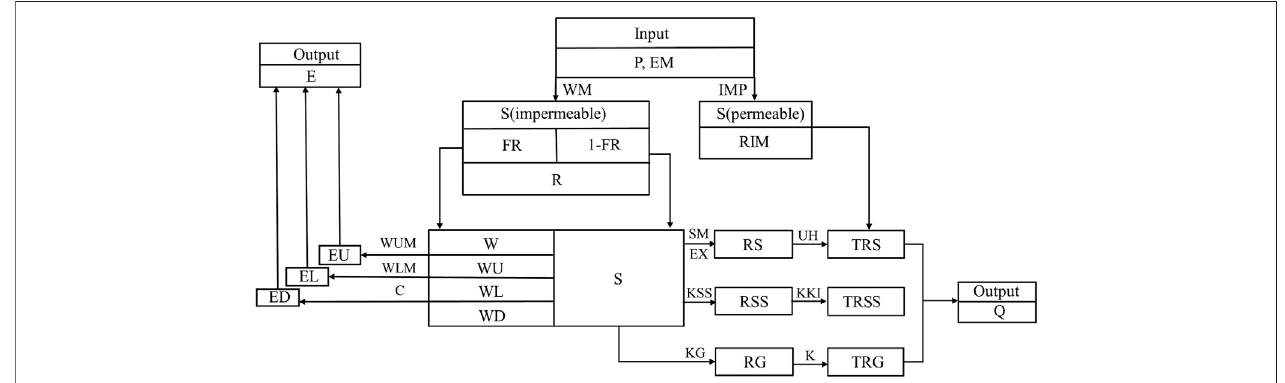
FIGURE 2 | Flow chart for the Xinanjiang model (XAJ) model (Zhao, 1992). Note: P, precipitation; EM, potential evaporation; S, free water storage; FR, area ratio with runoff generation; W, total soil moisture; WU, upper layer soil moisture; WL, lower layer soil moisture; WD, deeper layer soil moisture; EU, upper layer soil evaporation;EL,lowerlayersoilevaporation;ED,deeperlayersoilevaporation; E,actualevaporation; WUM,thesoilwaterstoragecapacityofupperlayer;WLM,thesoil waterstorage capacityoflowerlayer;, C,coef fi cient ofdeep evapotranspiration; SM, areal mean ofthefreewater capacity ofthesurface soil layer; EX, exponent of the free water capacity curve; KSS, out fl ow coef fi cients of the free water storage to inter fl ow; KG, out fl ow coef fi cients of the free water storage to groundwater; KKI, recession constant of the lower inter fl ow storage; K, recession constant of groundwater storage; UH, unit hydrograph; KG, coef fi cient of groundwater runoff; R, runoff generation; RS, surface runoff; RSS, inter fl ow runoff; RG, groundwater runoff; TRS, surface discharge; TRSS, inter fl ow discharge; TRG, groundwater discharge; Q, basin